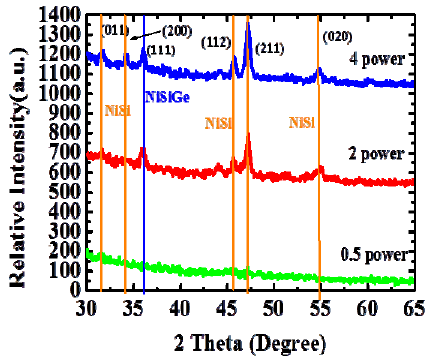
Figure 3. The GIXRD spectra for MWA with different power splits, confirming the NiSiGe formation.